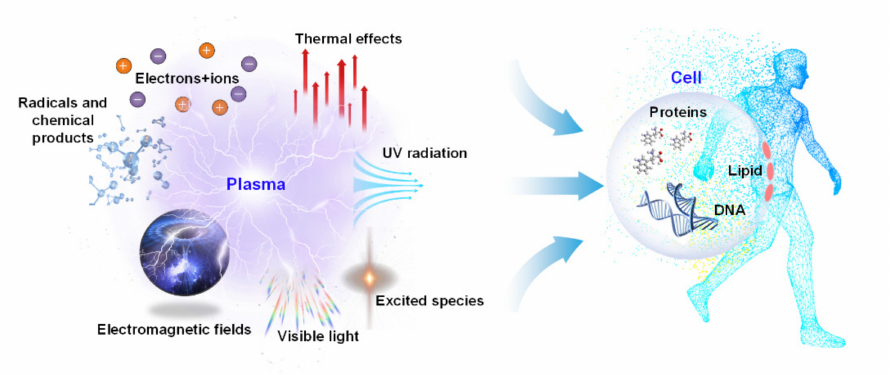
Figure 1. Schematic of the complex interactions between CAPs and treated biological targets